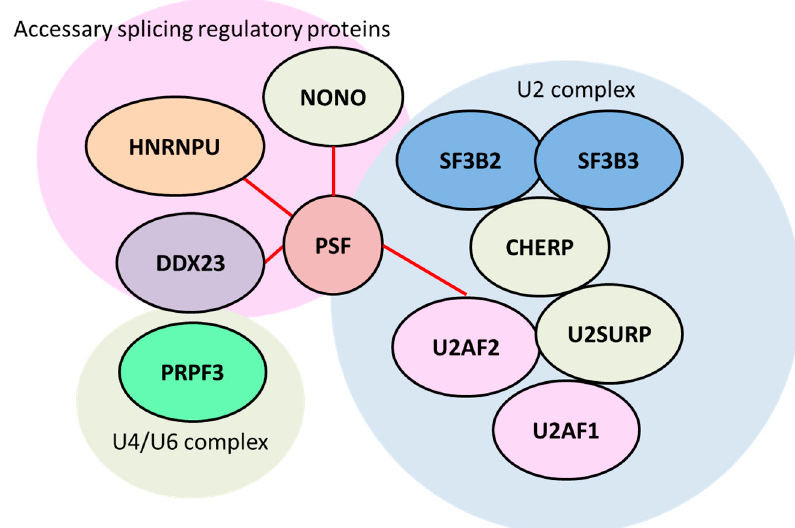
Figure 3. Splicing factor proline- and glutamate-rich (PSF) governs splicing factor complexes in advanced prostate cancer that are involved in AR and cancer-related gene expression. RNA-precipitation and sequencing studies (RIP-seq) revealed that PSF binds to a variety of splicing factors that are uniformly induced in metastatic castration-resistant prostate cancer (CRPC) tissues. The identified PSF-regulated splicing factors that are involved in AR and AR-V7 production are shown. The red line indicates protein – protein interaction validated by immunoprecipitation analysis [57]. HNRNPU: heterogeneous nuclear ribonucleoprotein U. PRPF3: pre-mRNA processing factor 3. CHERP: calcium homeostasis endoplasmic reticulum protein. DDX23: DEAD (Asp-Glu-Ala-Asp) box (DDX) 23. NONO: non-POU domain-containing octamer-binding protein.